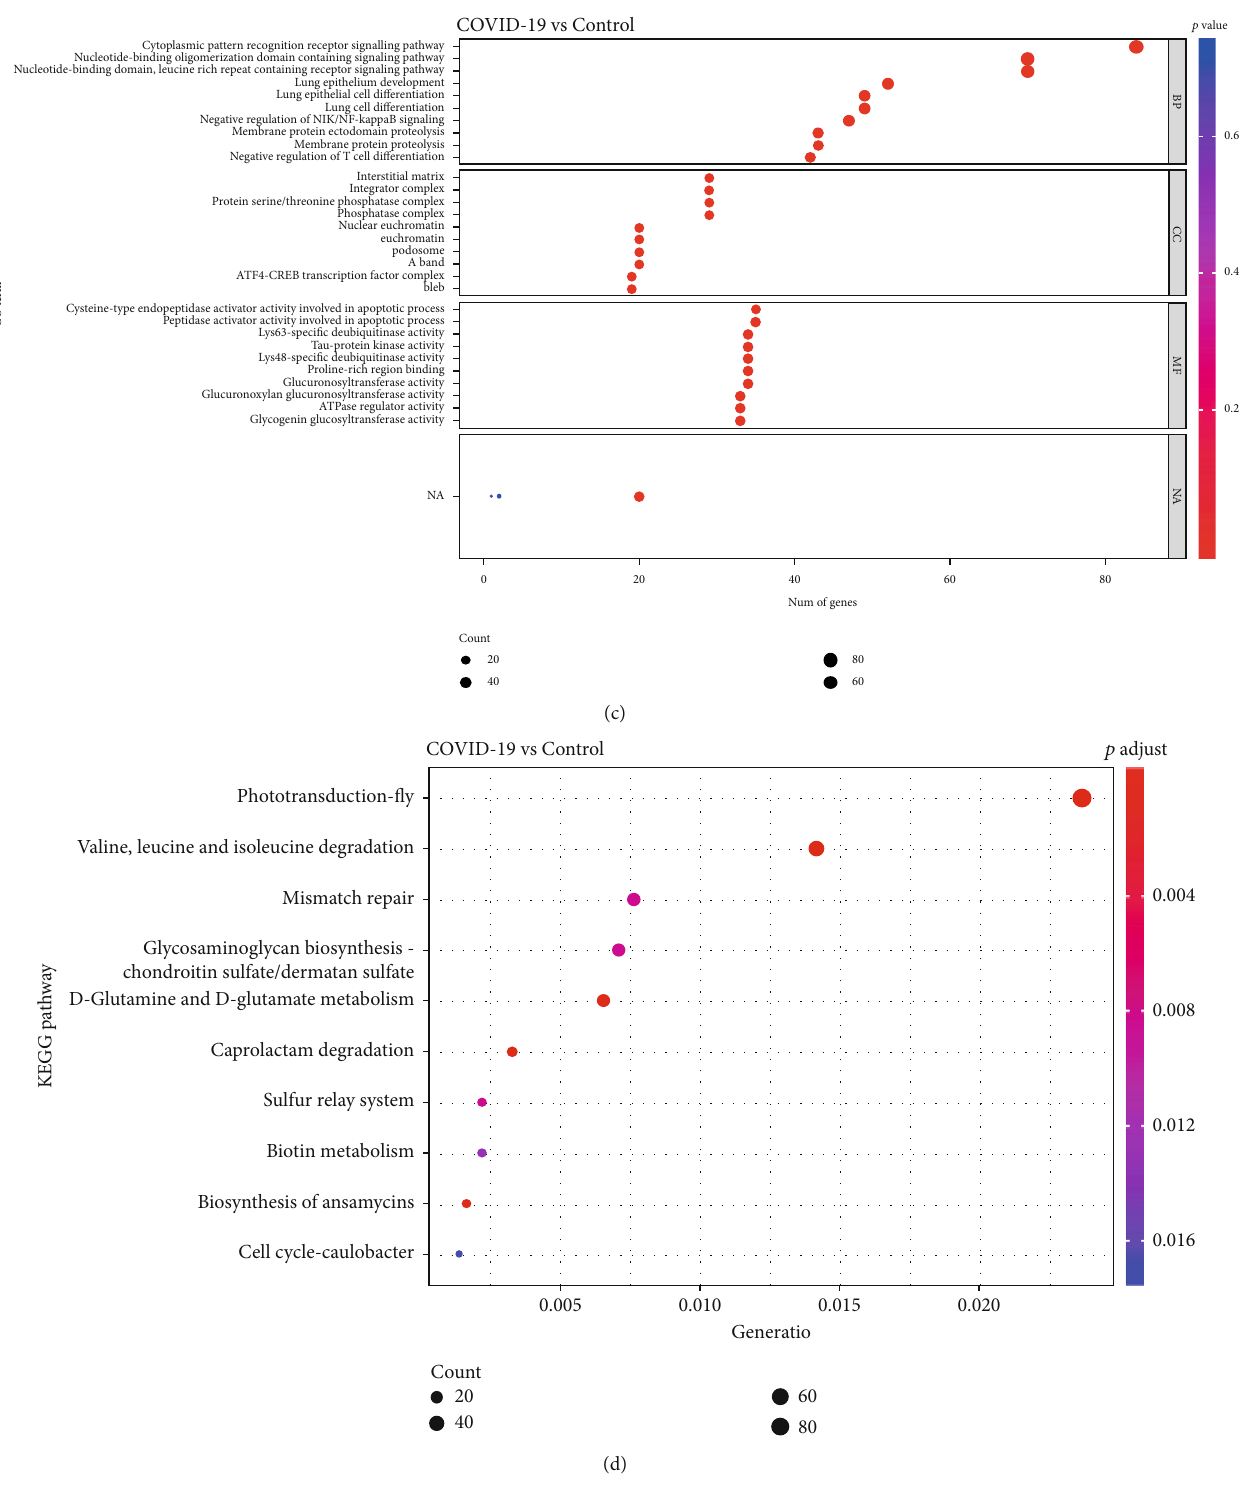
Figure 4: Functional enrichment analyses for target genes of DE miRNA and DE lncRNAs. Bubble plot shows GO (a) and KEGG terms (b) enriched in target genes of DE miRNA. Bubble plot shows GO (c) and KEGG terms (d) enriched in genes regulated by DE